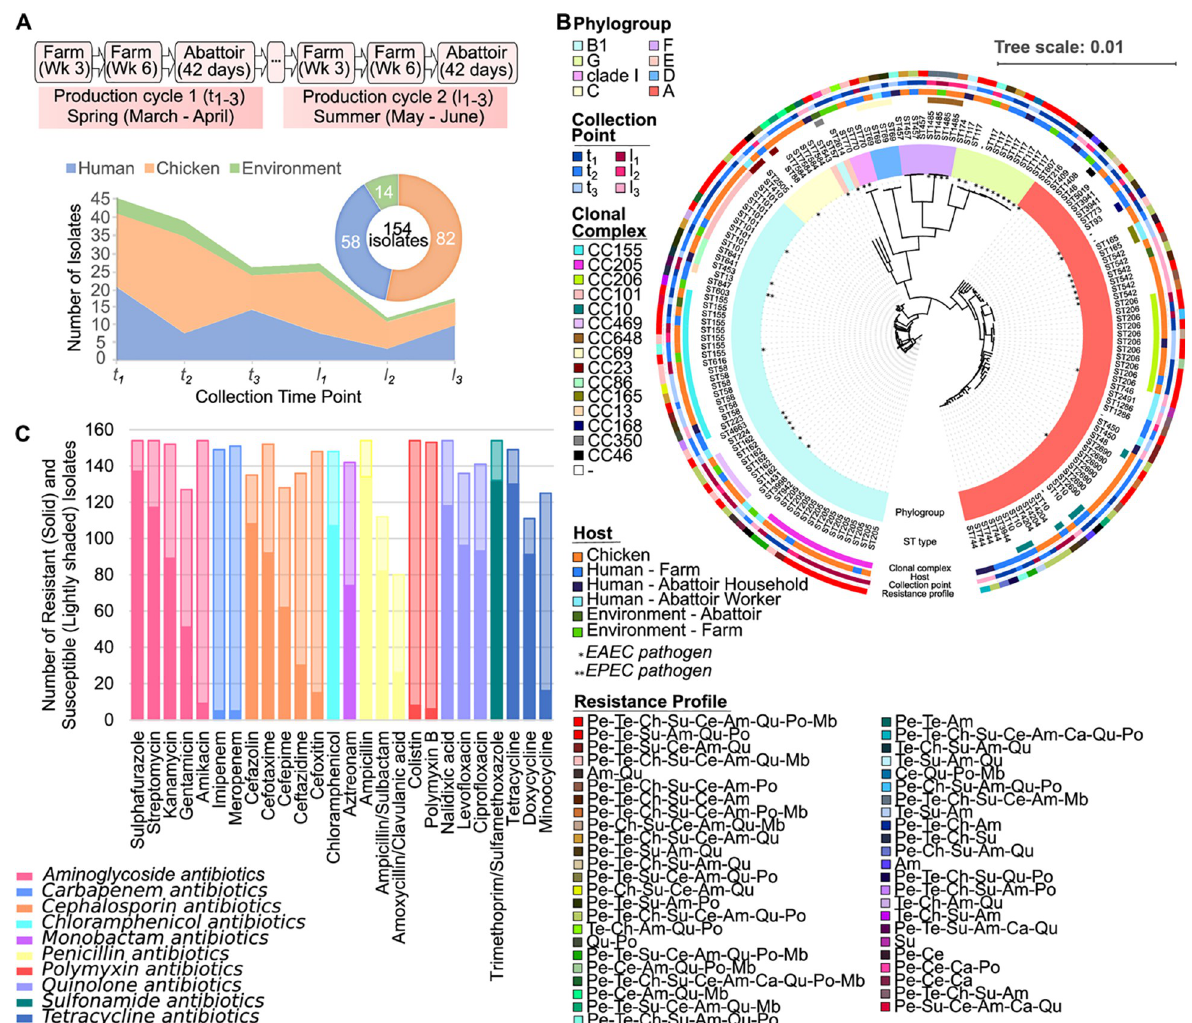
Fig 1. A wide array of non-pathogenic and pathogenic E . coli with phylogenetic intermixing, and high prevalence of shared multidrug resistances amongst livestock, humans, meat and environment are present in a poultry farm and the contracted slaughterhouse. (A) Overview of the study design and cohort information. 154 human, animal, meat and environmental samples were collected at each of three time points (denoted t1-3 and l1-3) over two independent 6-weeks broiler production cycles over one farm as well as the abattoir linked to this farm in China. The total number and type of isolates cultured and sequenced by host and host body site are shown. (B) Maximum likelihood phylogenetic tree of the whole cohort based on core genome of the 154 isolates with recombination correction, cultured from the human, animal and environmental and meat samples collected from the farm and slaughterhouse. Phylogroups (inner ring), sequence types, clonal complex, collection time points, host type and resistance profile (outer ring) are shown around the outside of tree. EAEC and EPEC isolates indicated by ⁕ and ⁕⁕ respectively. (C) Numbers of susceptible and resistant isolates, based on antimicrobial susceptibility testing by broth microdilution, for each of a panel of 26 antimicrobials encompassing nine different antimicrobial groups. core genome (2788 genes, present in � 99% of isolates) was constructed. The tree coupled with the in silico typing demonstrated high genetic diversity overall with phylogenetic inter- mixing between isolates from human and livestock (Fig 1B). The cohort spanned six of the seven common phylogroups (A, B1, C, D, E and F) as well as the more recently identified G and clade I groups (S1 Table). Phylogroups were not significantly associated with a host (chi- squared test with p-value < 0.05) or farm/slaughterhouse environment (chi-squared Bonferonni p-value < 0.05). Multi-locus sequence typing revealed diversity with 52 different Bonferonni